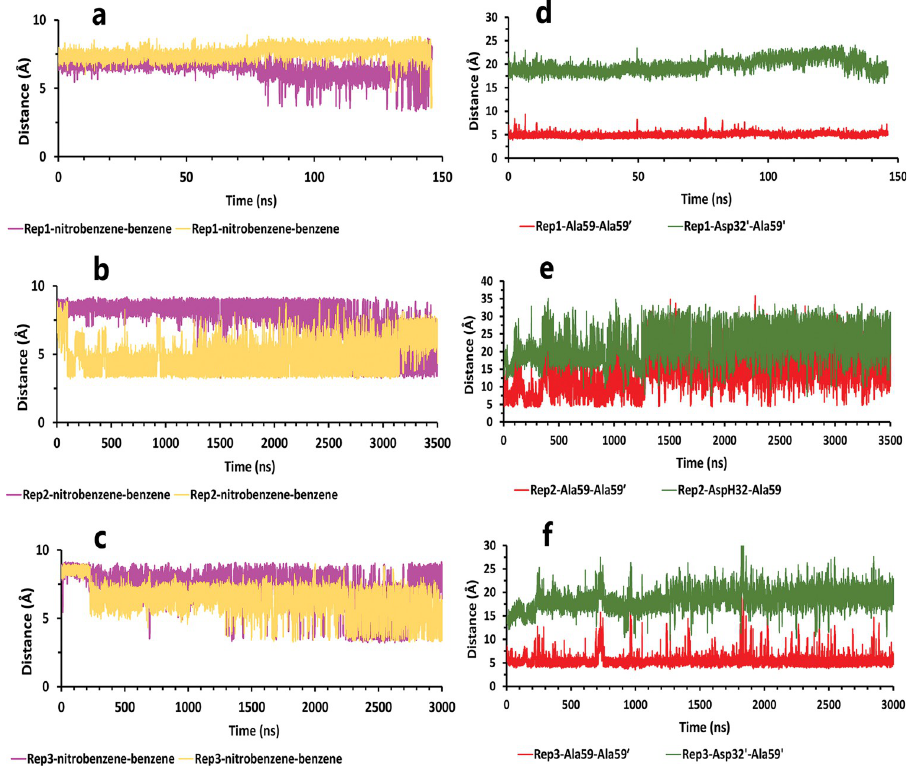
Fig 11. The details of distances between particular parts in compound 9 in complex with HTLV-1 protease, when Asp32 of chain B was protonated, in three replicas. A , B , and C , The distance between COMs of both nitrobenzene